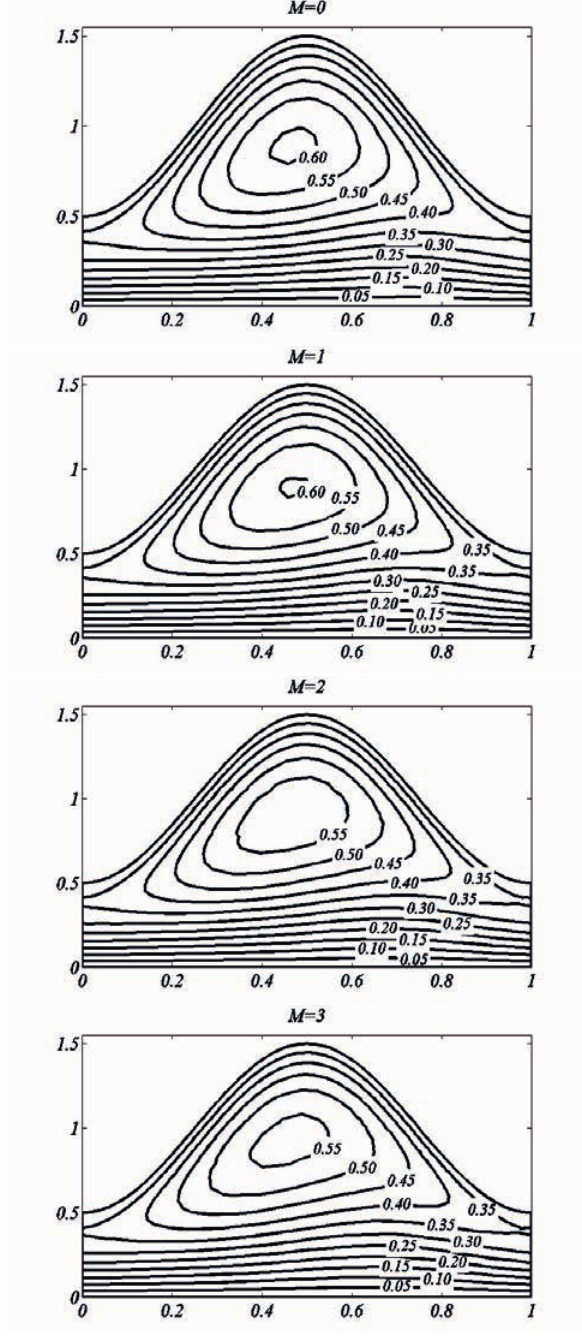
corresponds to augmented pumping region while Δ P = 0 is the free pumping region and Δ P < 0 is the co-pumping region. The pressure rise was plotted against time mean flow rate to see the effect of change in values of